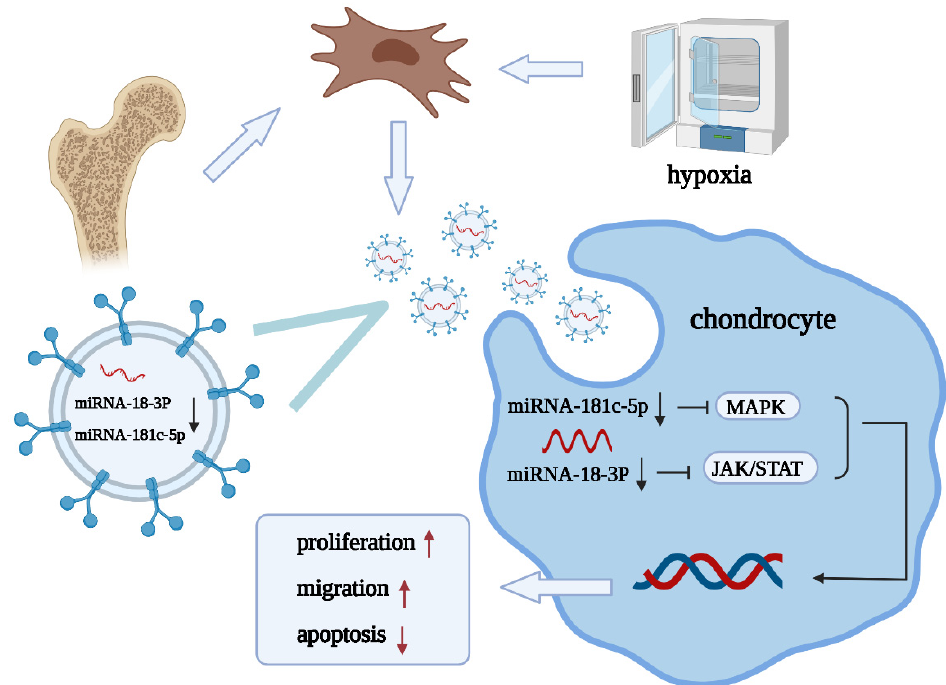
Figure 6. Diagram illustrating the proposed mechanism of action of hypoxia-preconditioned BMSC- EVs in OA.